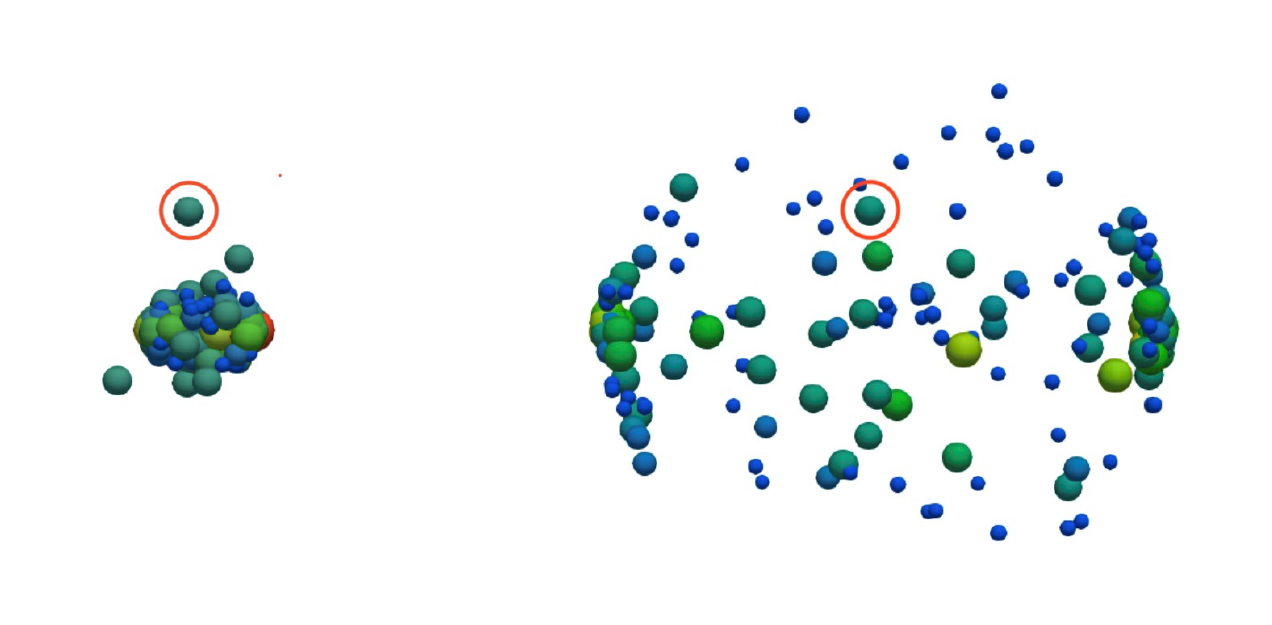
Figure 1. Schematic picture of the p+C+p TNC at the center-of-mass collision energy of protons √ s = 2.76 TeV. It visualizes the results of the UrQMD 3.4 simulations for t = 5 fm ( left panel ) and for t = 8.4 fm ( right panel ) after first collision of protons. The volume V h of particles is proportional to their mass m h for a better perception. The encircled nucleon shown in both panels does not leave its position during the reaction.